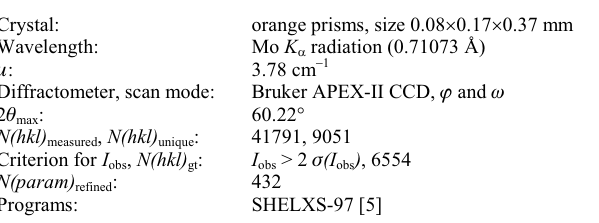
Table 1. Data collection and handling.